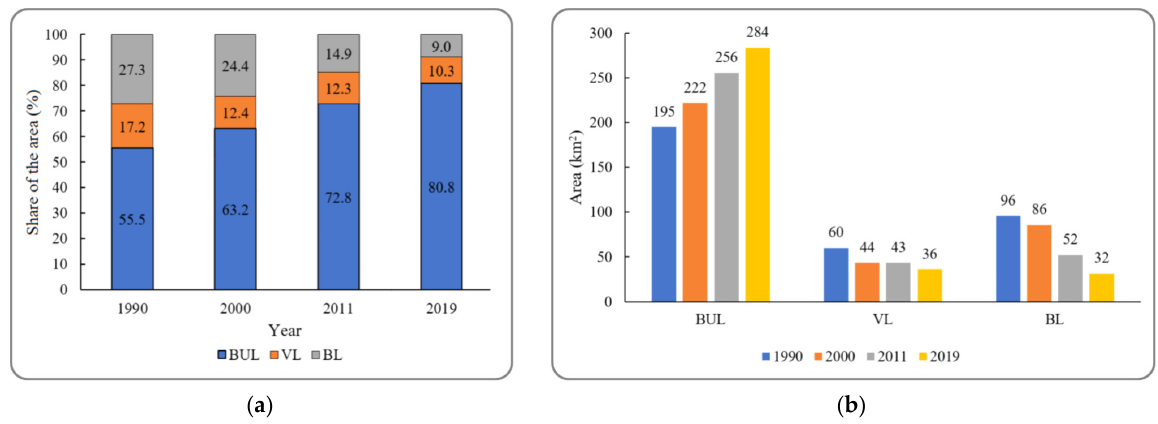
Figure 5. The area of the city of Mashhad occupied by built-up land (BUL), vegetated land (VL), and bare land (BL) calculated for the four points in time, namely, 1990, 2000, 2011, and 2019 ( a ), and the share of the area of each LU/LC class for Mashhad for the same years ( b ).